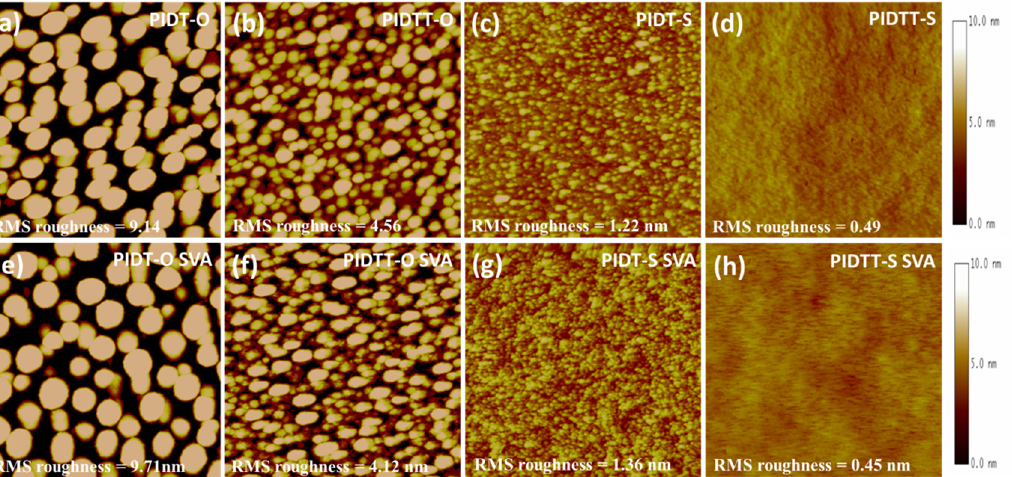
Figure 5. Surface topographic AFM images of polymer: PC 71 BM blend films ( a ) PIDT-O, ( b ) PIDTT-O, ( c ) PIDT-S, ( d ) PIDTT-S without SVA treatment, and ( e ) PIDT-O, ( f ) PIDTT-O, ( g ) PIDT-S, ( h ) PIDTT-S with SVA treatment.